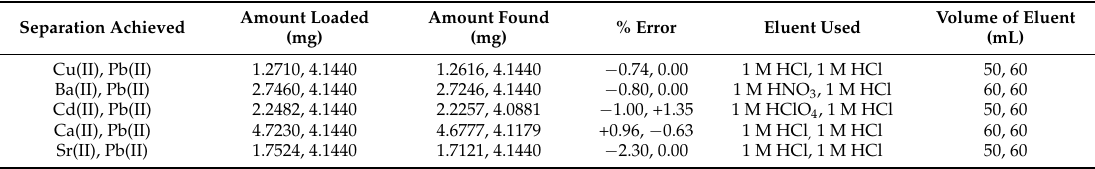
Table 6. Some binary separations of metal ions achieved on graphene Th(IV) phosphate. Separation Achieved